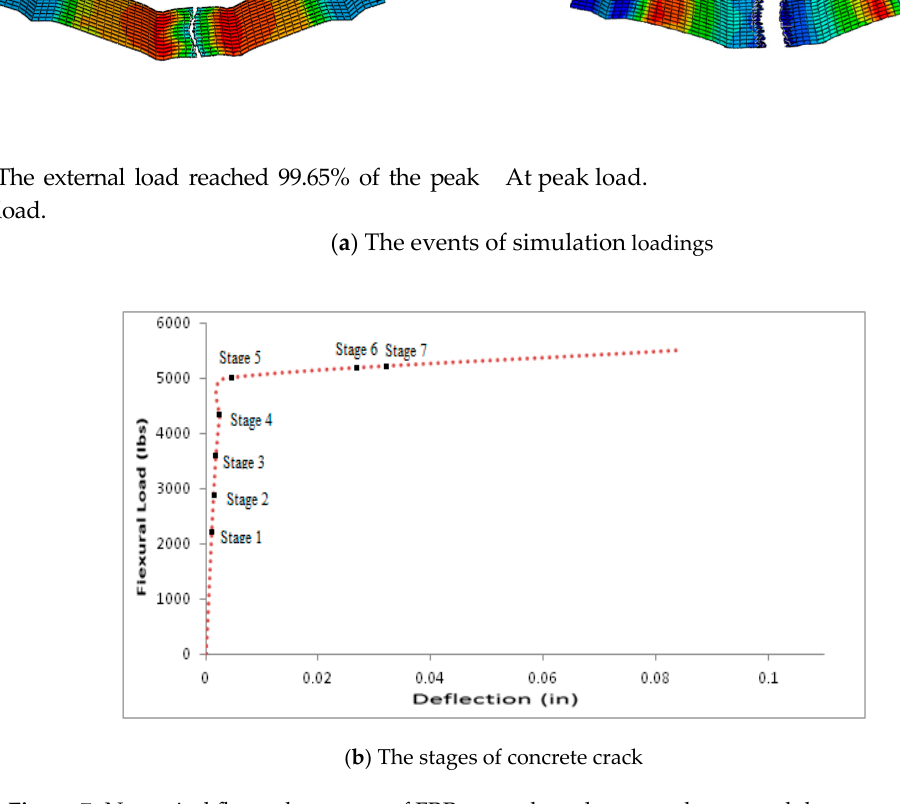
Figure 7. Numerical flexural response of FRP strengthened concrete beams and the stages of concrete crack at RT. ( a ) The events of simulation loadings; ( b ) The stages of concrete crack. As shown in Figure 7, the first concrete crack started when the external load reached 40.75% of the peak load and FRP delamination started when the external load reached 95.07% of the peak load.